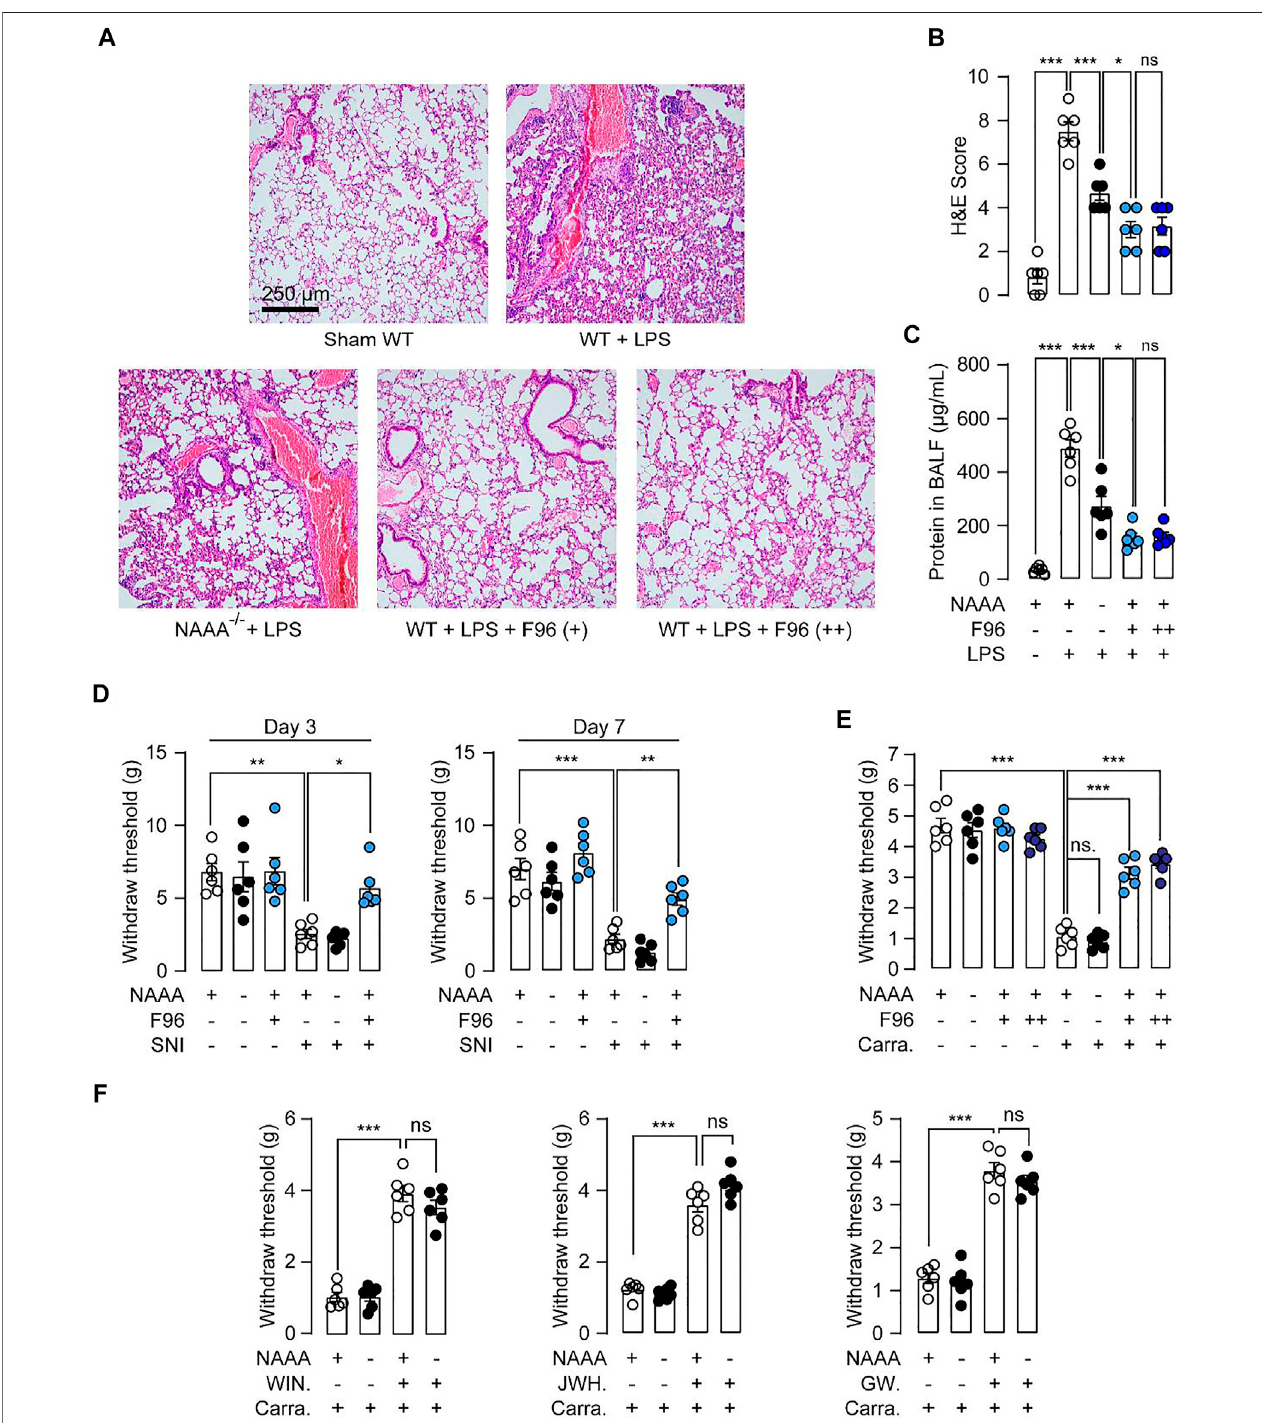
FIGURE4| Genetic inactivation ofNAAAcausesanalgesicand anti-in fl ammatorytolerance. (A,B) WTand NAAA − /- mice wereinstilledintratracheallywithsaline or LPS, following by treatment with vehicle or F96 (30 mg/kg, +, i.v ., 6 h after LPS administration). In separate groups of WT mice, F96 (30 mg/kg, ++) was intravenously injected once daily for 7 days, fi nal dose was administered 6 h after LPS administration. H&E staining lung sections of sham and ALI mice sacri fi ced 24 h after LPS administration. (C) Protein concentrations in BALF in sham and ALI mice. (D) WT and NAAA -/- mice were received sham or SNI operation, following by treatment withvehicleorF96(30 mg/kg, i.v .,oncedailyfor7days),andmeasuredhyperalgesiaatday3and7postsurgery.( E,F )WTandNAAA − /- micewereintra-plantarinjected with 1% λ -carrageenan or its saline vehicle. WIN55,212-2 (2 mg/kg), JWH-133 (2 mg/kg), GW6471 (2 mg/kg), F96 (30 mg/kg, +) or vehicle were intravenously ( i.v. ) injected 2 h after carrageenan administration. In separate groups of WT mice, F96 (30 mg/kg, ++) was intravenously injected once daily for 7 days, fi nal dose was administered2 haftercarrageenaninjection.Hyperalgesiawasmeasuredat6 haftercarrageenaninjection.Dataareexpressedasmean ± SEM( n (cid:1) 5 – 6).*, p < 0.05;**, p < 0.01; ***, p < 0.001 by one-way ANOVA.